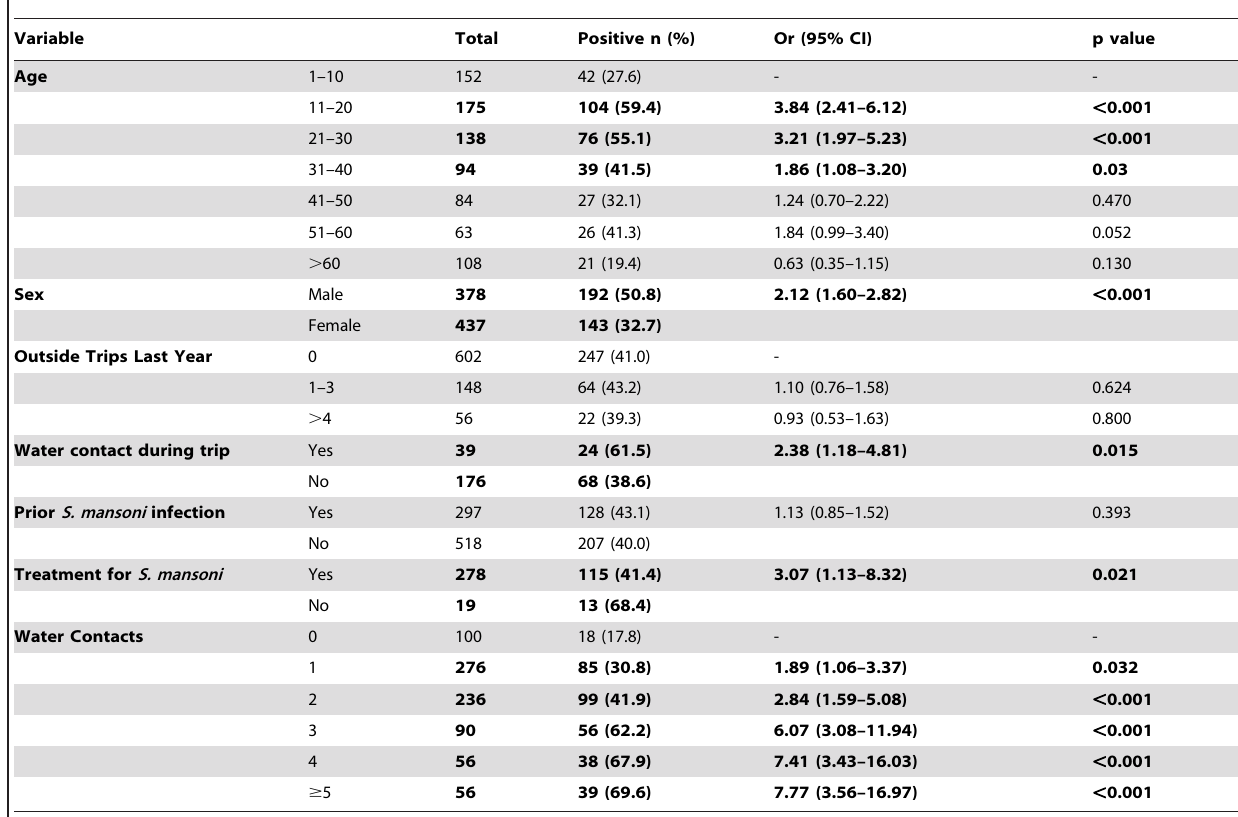
Table 2. Risk for S. mansoni egg positive stools.